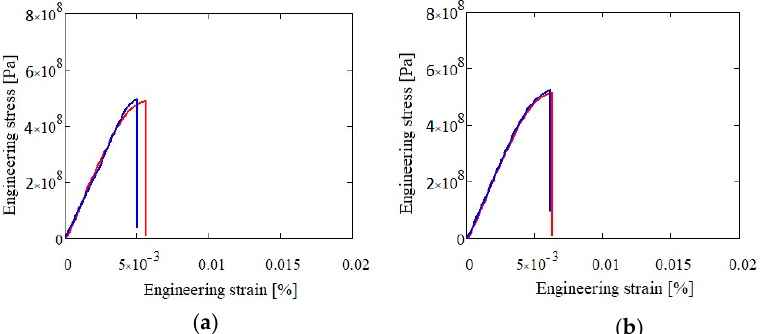
Figure 23. Compression test results for as-cast ( a ) and heat treated ( b ) Al 3 Mn 0.2 Zn 0.3 Mg 0.7 Si 0.8 alloy.